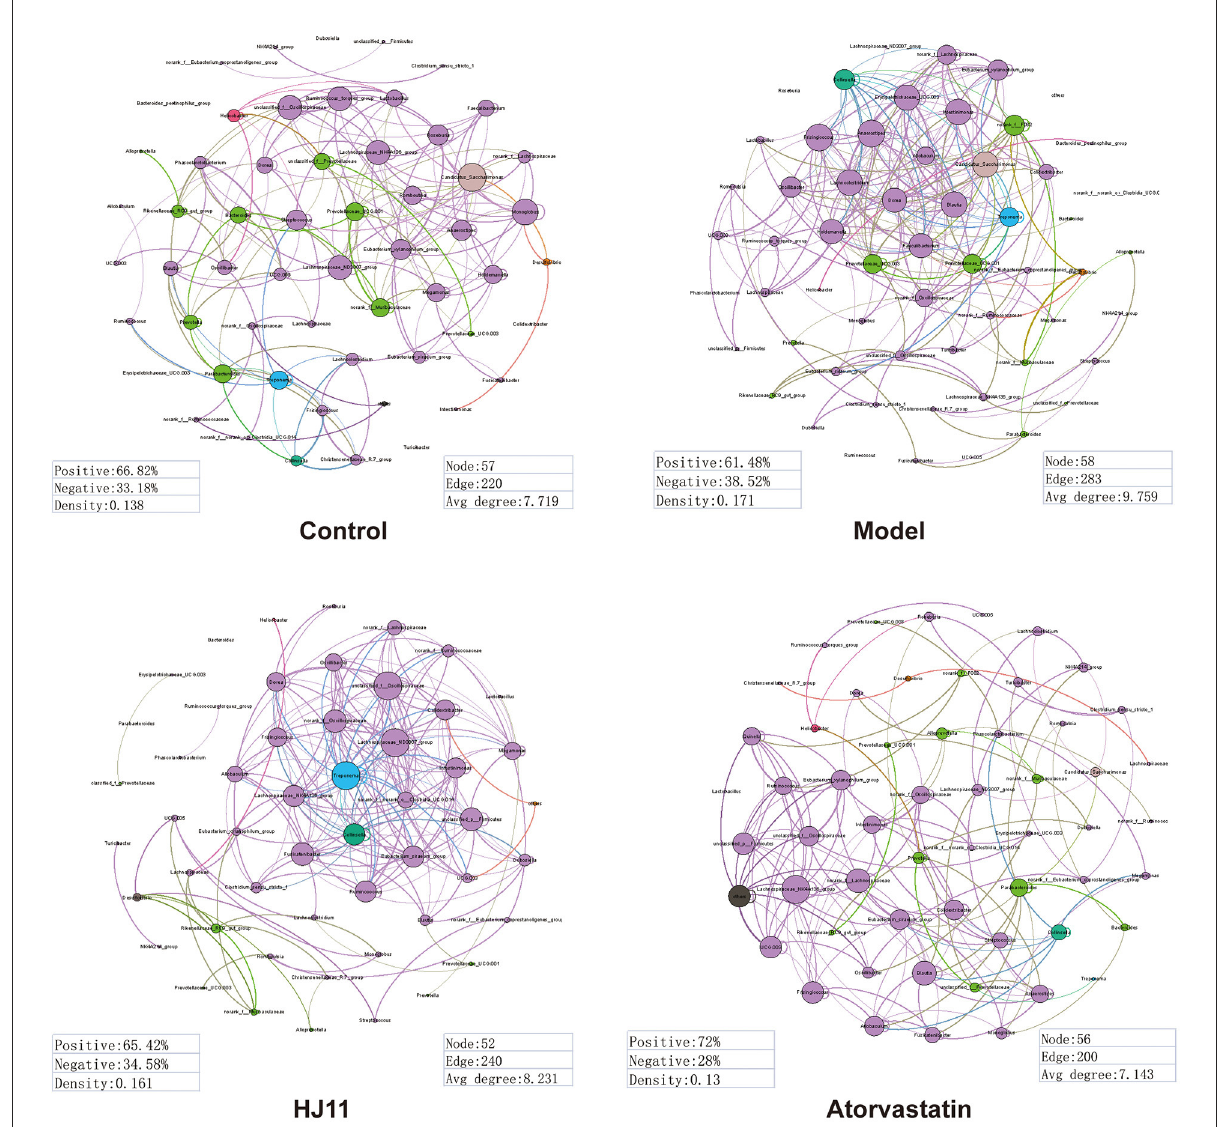
FIGURE5 Dominant phylotypes (relative abundance > 0.05) in different groups. Connection indicates strong (Spearman’s r > 0.8) and significant ( P < 0.001) correlation. The co-occurrence network is colored according to the phylum or genus. The size of each node is proportional to the relative abundance of each phylotype. The thickness of each connection between two nodes (edge) is proportional to the Spearman’s correlation coefficient. Purple edge indicates positive correlation between two nodes. Green edge indicates negative correlation between two